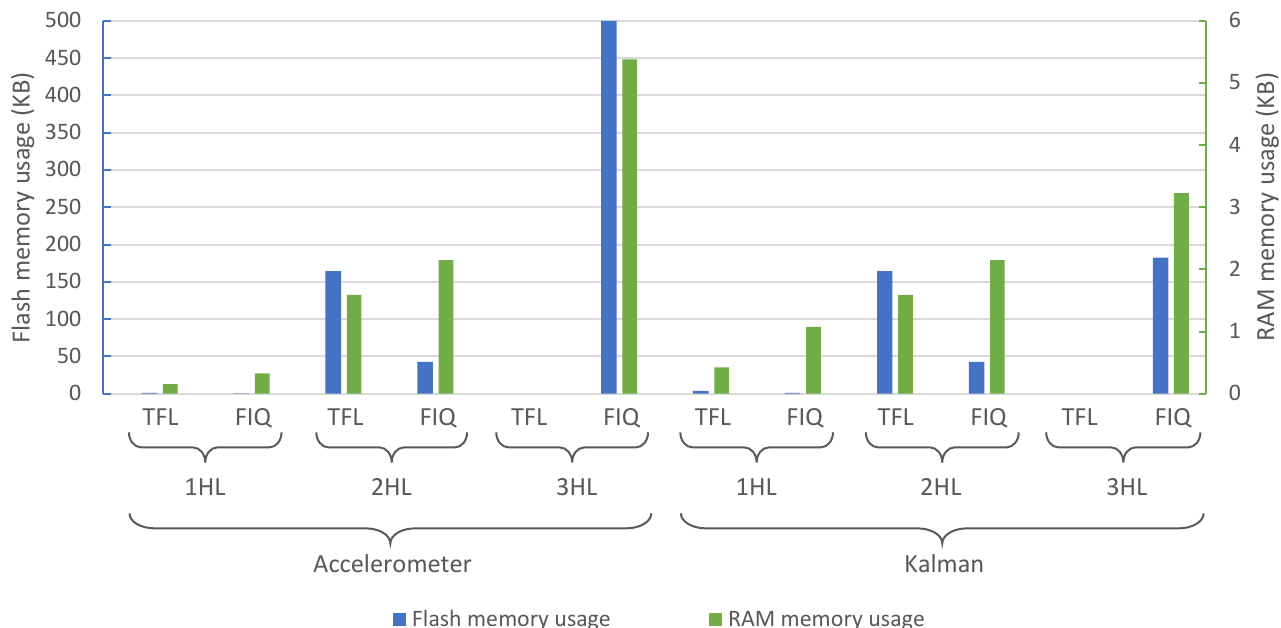
Figure 7. Flash memory usage for each of the studied models and hardware platforms.